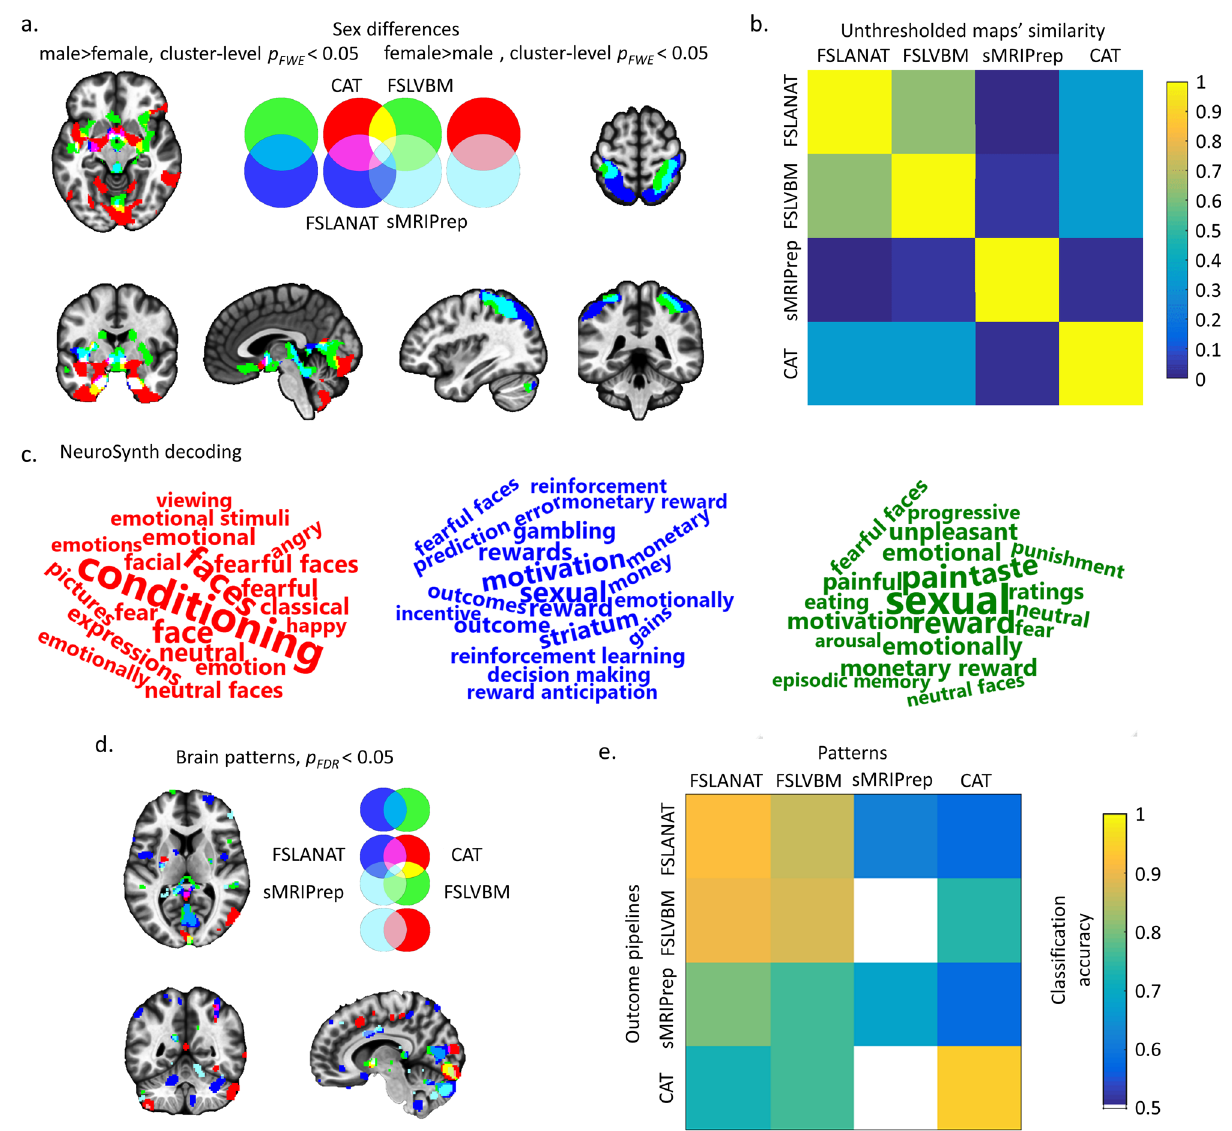
Fig. 3 Univariate and multivariate analyses determining GMV sex differences. a Results from parametric statistics showing between-pipeline overlap at a cluster-level p FWE < 0.05 with initial cluster forming voxel level p < 0.001. The left panels of a display results for the male>female contrast. The right panels of a correspond to the female > male contrast. For a and d the pipelines are coded as: red = CAT, green = FSLVBM, blue = FSLANAT, light blue = sMRIPrep, additional colors visualize the overlap between the results, e.g., CAT ∩ FSLVBM = yellow, CAT ∩ FSLANAT = purple, FSLVBM ∩ FSLANAT = light blue, CAT ∩ FSLVBM ∩ FSLANAT = white and etc. b The variability of unthresholded statistical maps. The correlation values between whole-brain unthresholded statistical maps of four pipelines were computed respectively for sex differences. Only positive values are visualized for display purpose. c Decoding the functional properties of the identi fi ed brain regions of male > female ( a , red = CAT, green = FSLVBM, blue = FSLANAT, no difference in sMRIPrep) using NeuroSynth. Only the top 20 functional terms are visualized. The font size re fl ects the size of the correlation. d Reliable brain patterns to distinguish sex differences via bootstrapping test (5000 permutations, p FDR < 0.05), and e cross-predicted accuracy of four p ipelines in independent samples. The color from cold to warm indicates increasing classi fi cation accuracy (from 0.5 to